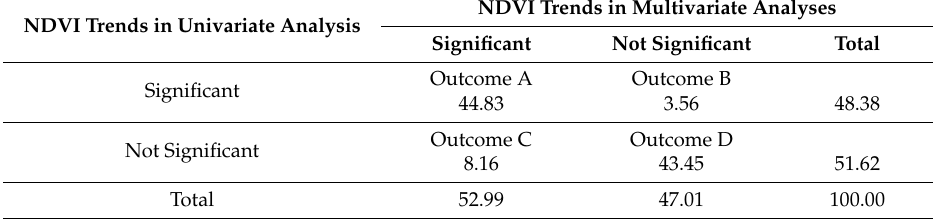
Table 3. Frequency of outcomes in comparison of NDVI trends between univariate and multivariate analyses for ~7,660,636 1 km × 1 km pixels in conterminous states. Outcomes A and C denote changes due to direct factors, Outcome B denotes changes due to climatic factors, and Outcome D denotes no change in greenness.